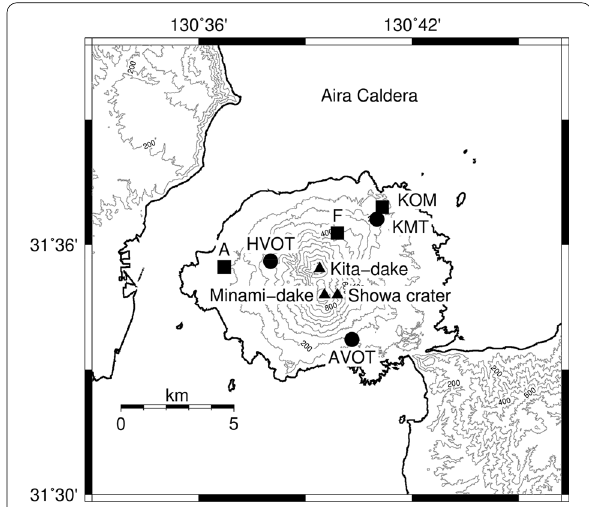
Fig. 1 Distribution of tilt and strain stations used in the present study. The solid circles represent the Arimura (AVOT), Harutayama (HVOT) and Komen (KMT) observation tunnels, where tiltmeters and strainmeters are located. The solid squares represent borehole tiltmeters of the Japan Meteorological Agency at Yokoyama ( a ) and Amida-gawa ( f ), and that of the Sakurajima Volcano Research Center of Kyoto University at Komen (KOM). The solid triangles represent the summit craters of Kita-dake and Minami-dake, and the Showa